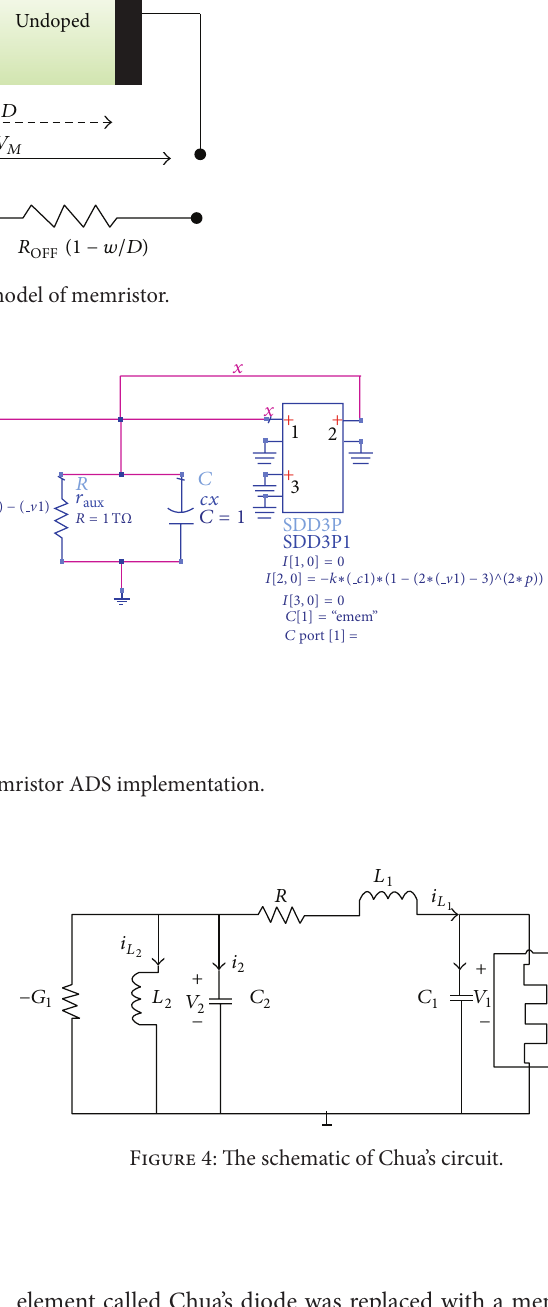
Figure 3: Memristor current versus voltage (hysteresis loop).